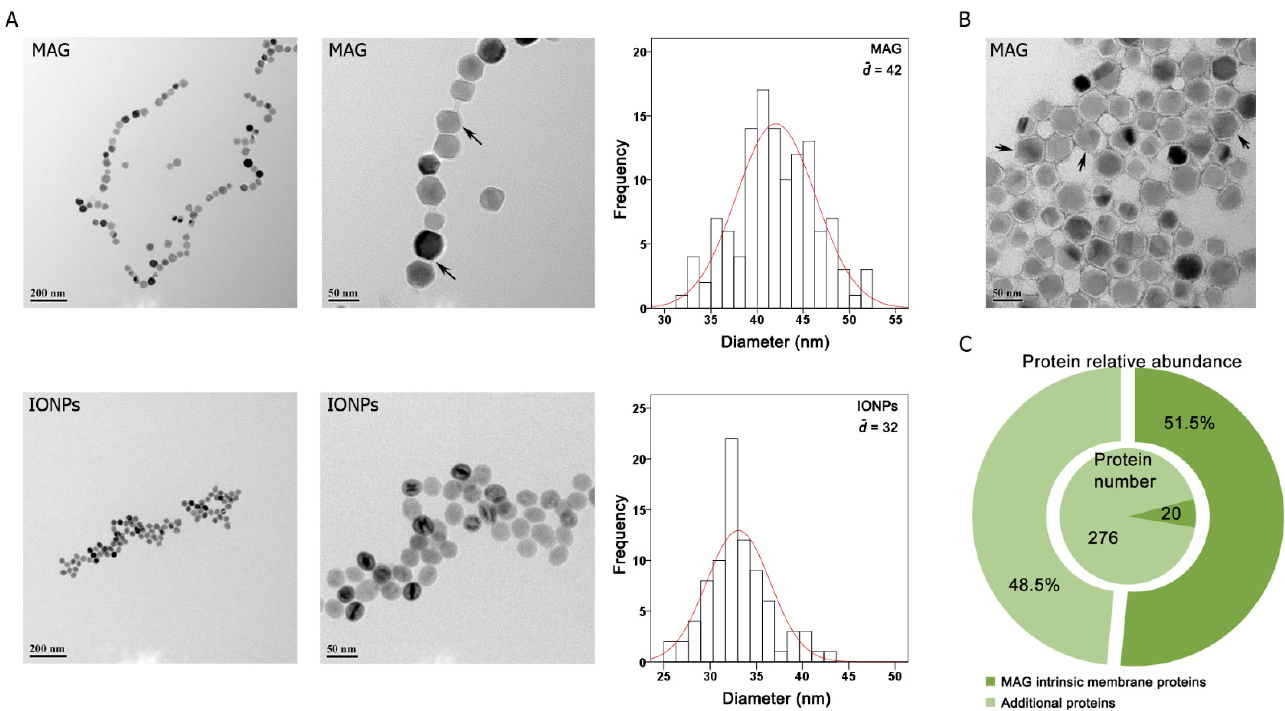
Figure 1. Characterization of nanoparticles. ( A ) TEM images of typical magnetosomes (MAGs) and amine magnetic iron oxide nanoparticles (IONPs). Arrows indicate MAG membrane. Frequency distributions show the particles size distribution of typical MAGs (~42 nm in diameter) and IONPs (~32 nm in diameter), as determined by TEM. ( B ) Negative staining TEM image of typical MAGs. The magnetite core is surrounded by an electron-light organic shell (indicated by black arrows), representing the membrane. ( C ) Proteomic analysis of MAGs protein composition and relative abundances. The identified proteins were classified into two groups (MAG intrinsic membrane proteins and additional proteins. Details are given in Supplementary Tables S1 and